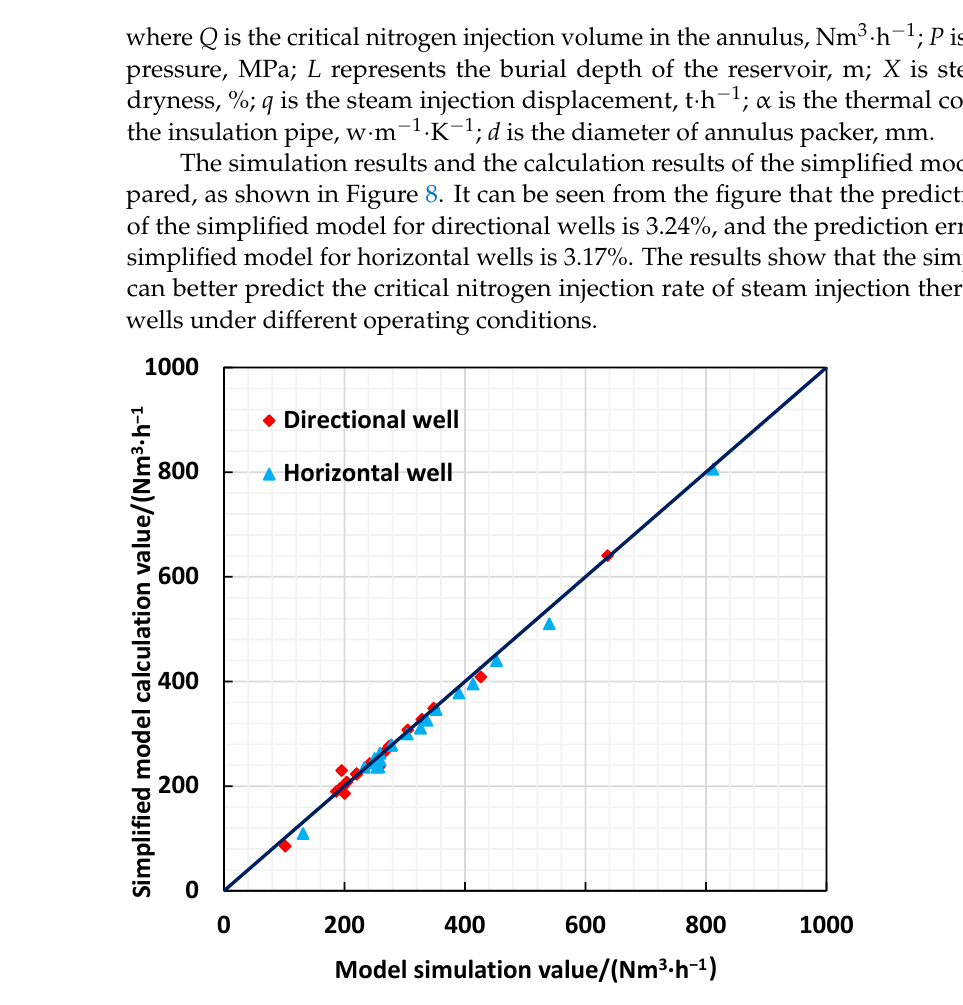
Figure 8. Comparison between the simulated values of the model and the calculated values of the simplified model.